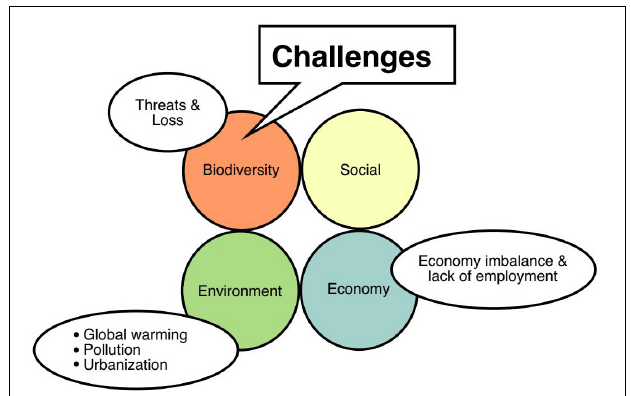
FIGURE 4 | Threats to sustainable